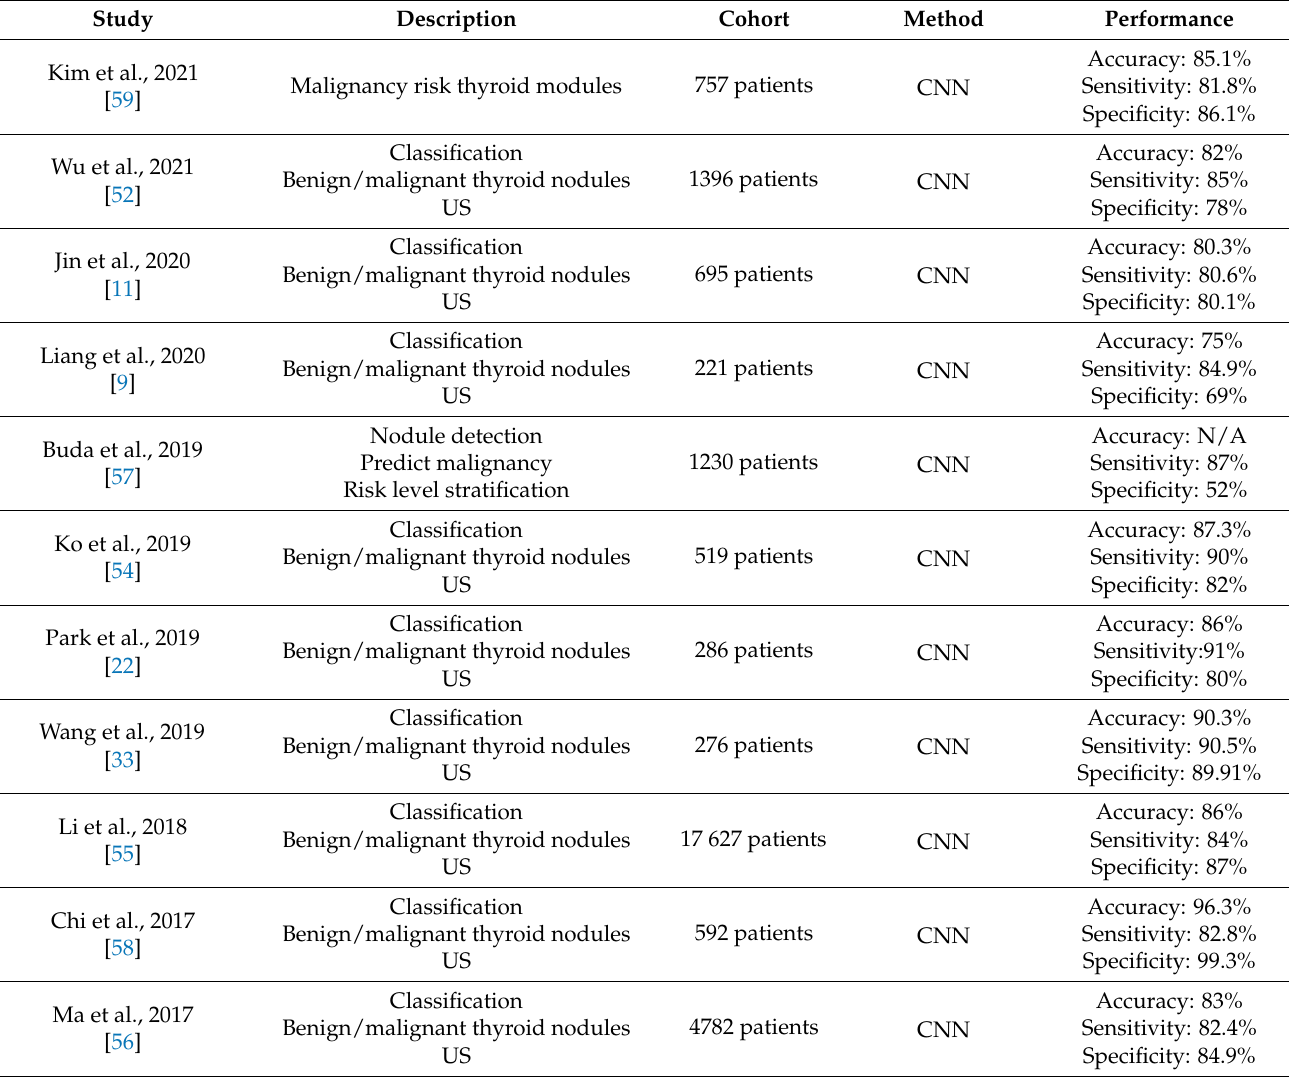
Table 2. Deep learning (DL)